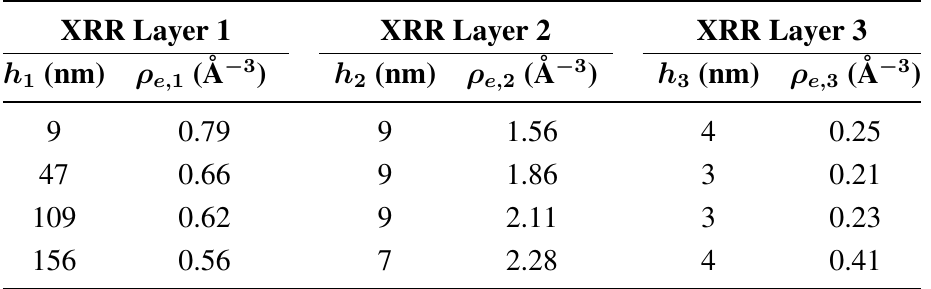
Data for brushes and brush/particle hybrids (AuNP-13) with varying brush thickness obtained by X-ray reflectivity (XRR) measured at ambient